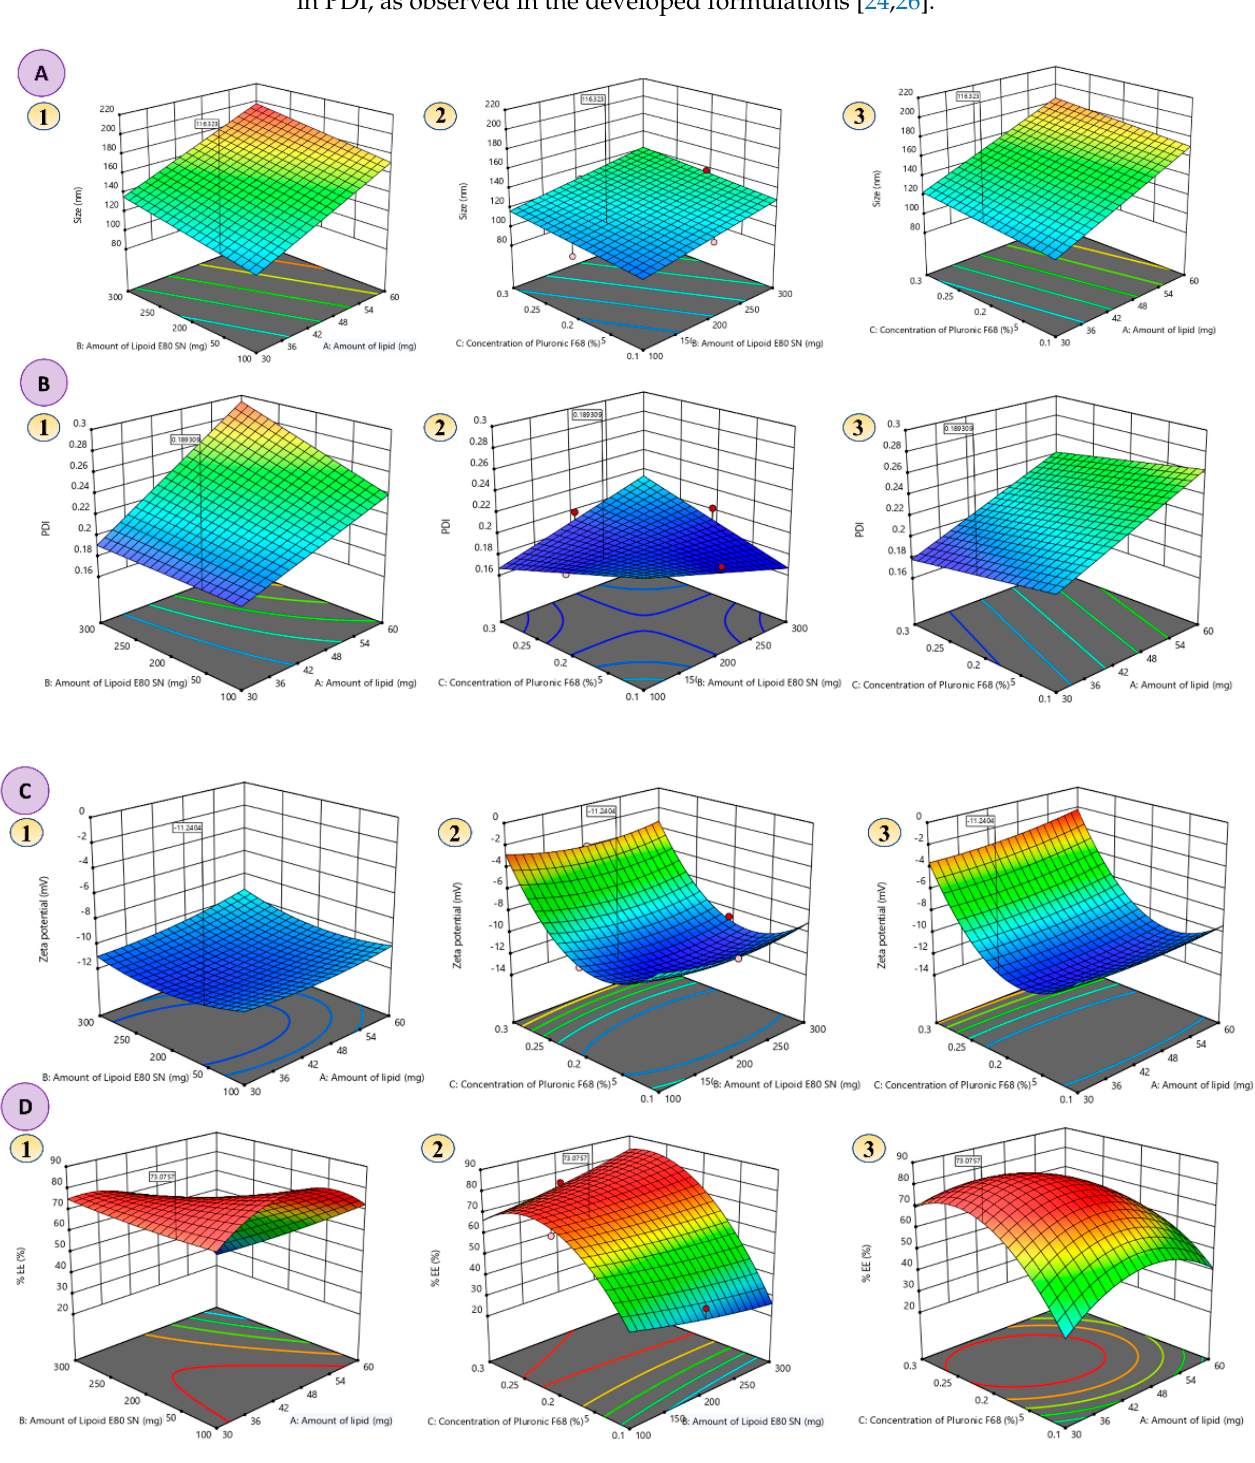
Figure 2. ( A – D ) 3D-response plots representing the effects of CMAs on ( A ) PS; (Effects of amount of lipid, amount of lipoid and concentration of PF-68 (1–3), ( B ) PDI; (Effects of amount of lipid, amount of lipoid and concentration of PF-68 (1–3) ( C ) ZP; (Effects of amount of lipid, amount of lipoid and concentration of PF-68 (1–3) and ( D ) %EE; (Effects of amount of lipid, amount of lipoid and concentration of PF-68 (1–3).